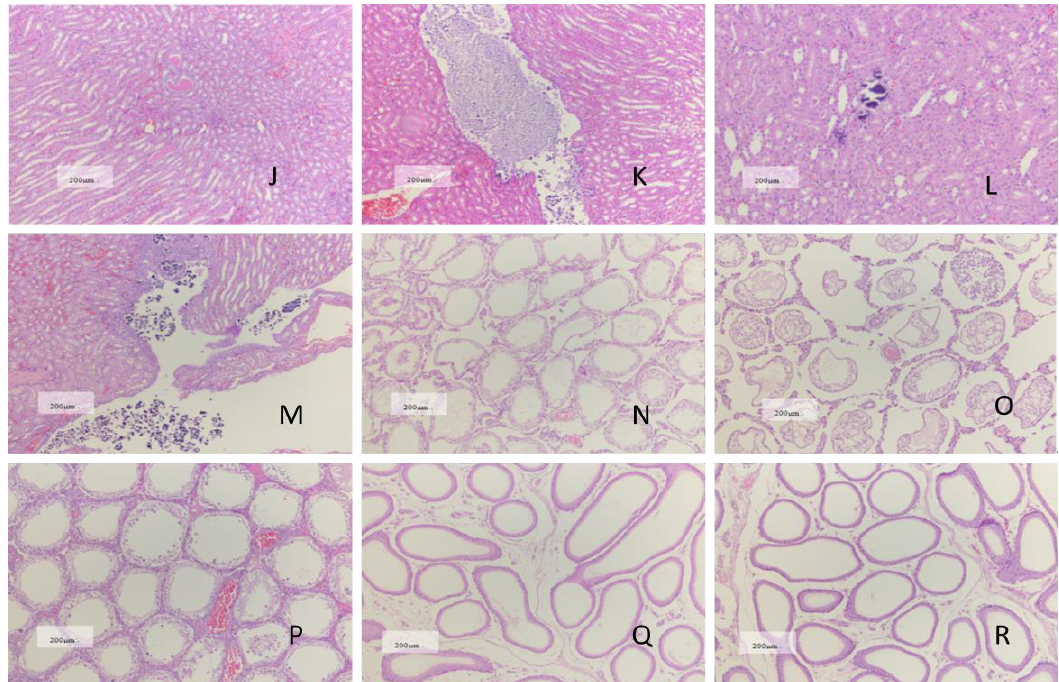
Figure 6. Non-specific histopathological changes in rats at week 13. ( A ): slight interstitial inflammation of lung in Jimai22 group; ( B ): Slight glandular dilatation of stomach in Jimai22 group; ( C ): slight inflammatory cells infiltration of liver in Jimai22 group; ( D , E ): slight hepatic vacuolation in Jimai22 and Gm group; ( F – H ): slight renal interstitial inflammatory cell infiltration in Control, Jimai22 and Gm group, respectively; ( I , J ): Slight renal hyaline casts in Jimai22 group and Gm group; ( K – M ): slight renal calcium deposition in Control, Jimai22 and Gm group, respectively; ( N – P ): testicular atrophy in Control, Jimai22 and Gm group, respectively; ( Q , R ): epididymal sperm loss in Control, Jimai22 group.